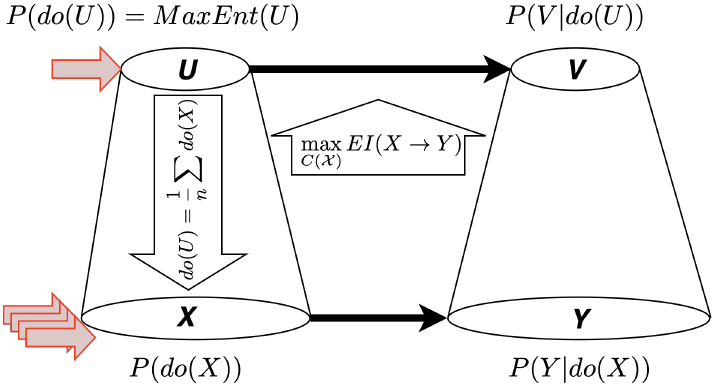
Figure 1. Hoel’s theory: Causal emergence occurs whenever effective information EI is maximized for a strict coarsening C ( X ) of the state space X of the underlying system. Note that X and Y are required to have the same state spaces (similarly, for U and V ). Setting macro variable U to state u by intervention do ( U = u ) maps to a uniform average over the interventions do ( X = x ) for those values x that correspond to the value u